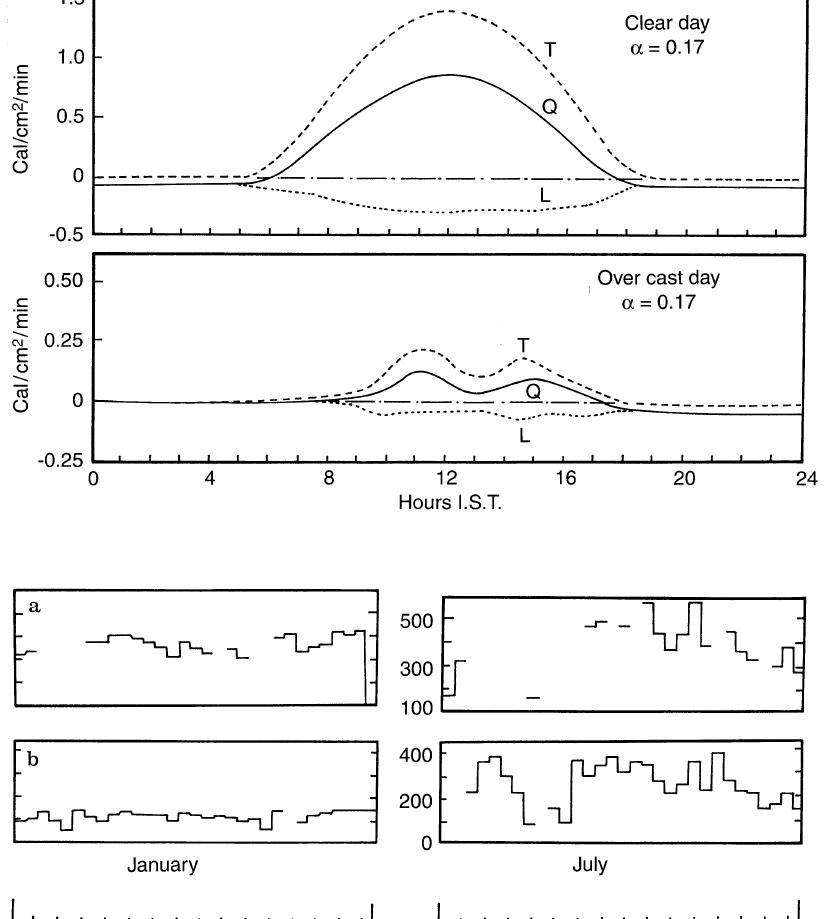
Fig. 3. a Global radiation and b net radiation ( (cid:93) 4.186 (cid:93) 10 (cid:52) ) in January and July at Calcutta in J · m (cid:126)(cid:50) · day